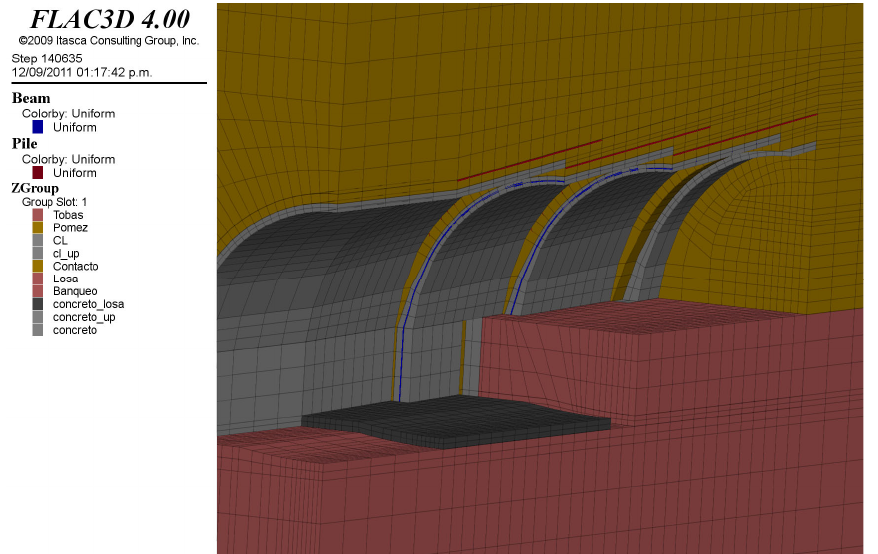
Figure 17. Mesh of finite differences for case (b).